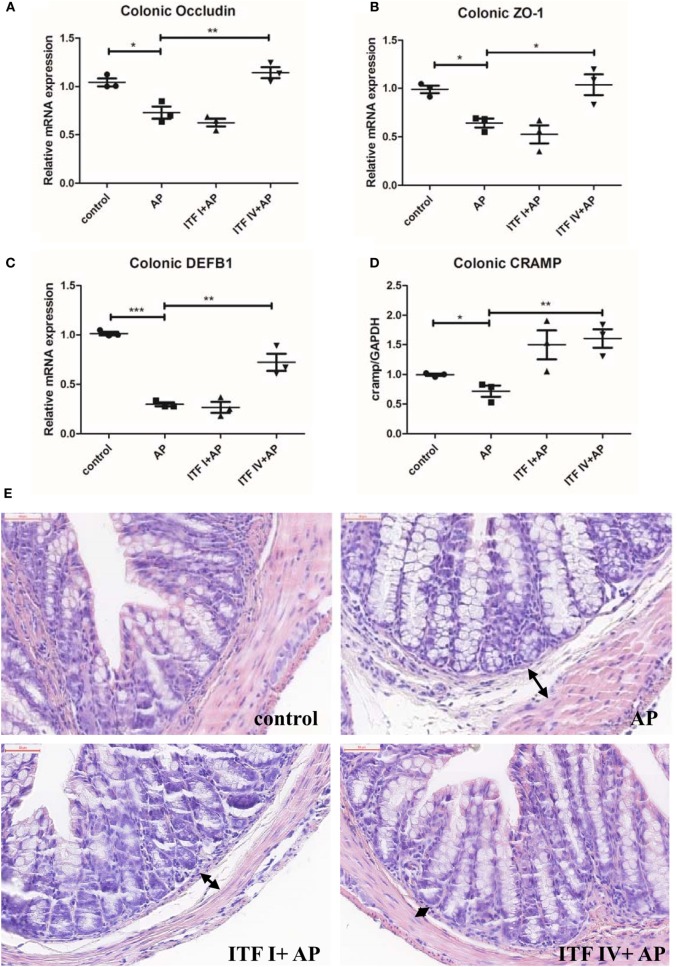
ITF IV upregulating TJ proteins and AMPs in the colon. Mice were fed with 5% ITF I or ITF IV supplemented diets for 72 h before AP induction by caerulein. The mRNA levels of TJ proteins occluding (A), ZO-1 (B), DEFB1 (C), and CRAMP (D) in the colon were then determined by RT-qPCR analyses. Representative photographs showed histomorphology of colonic tissues (50 µm) by H&E staining (E). Data shown are means ± SEM. *P < 0.05, **P < 0.01, and ***P < 0.001. AMPs, antimicrobial peptides; AP, acute pancreatitis; CRAMP, cathelicidin-related antimicrobial peptide; DEFB1, β-defensin-1; H&E, hematoxylin and eosin; ITF, inulin-type fructans; RT-qPCR, real-time quantitative polymerase chain reaction; SEM, standard error of mean; TJ, tight junction; ZO-1, zonula occludens-1.